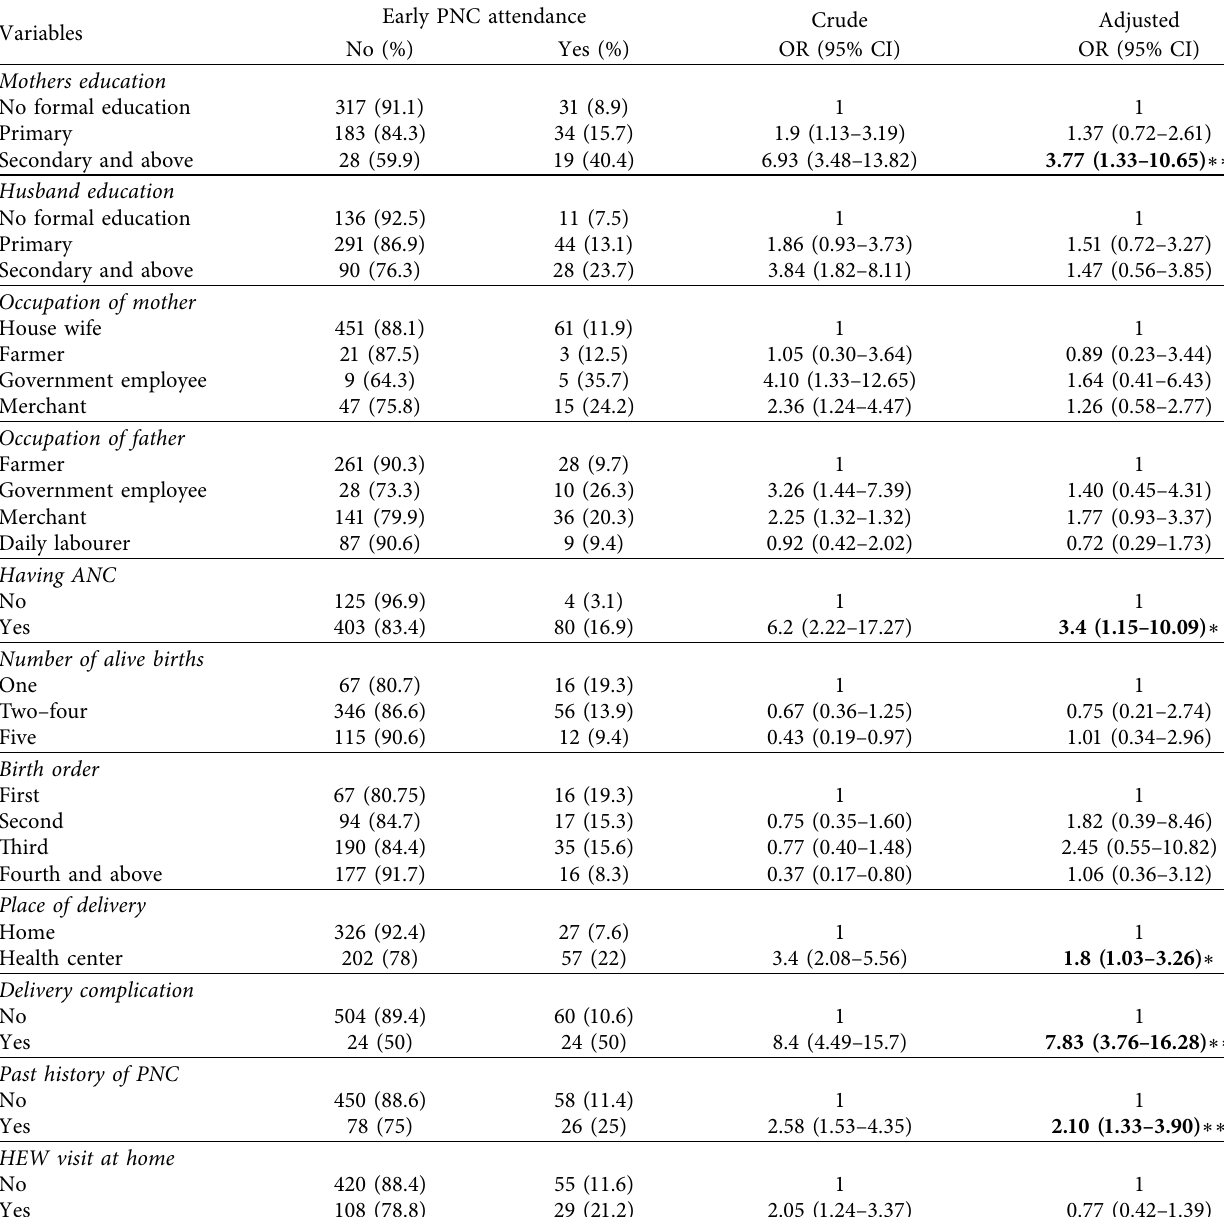
Table 5: Multivariable analysis of factors associated with early PNC utilization of mothers at Wonago District, South Ethiopia, 2017.